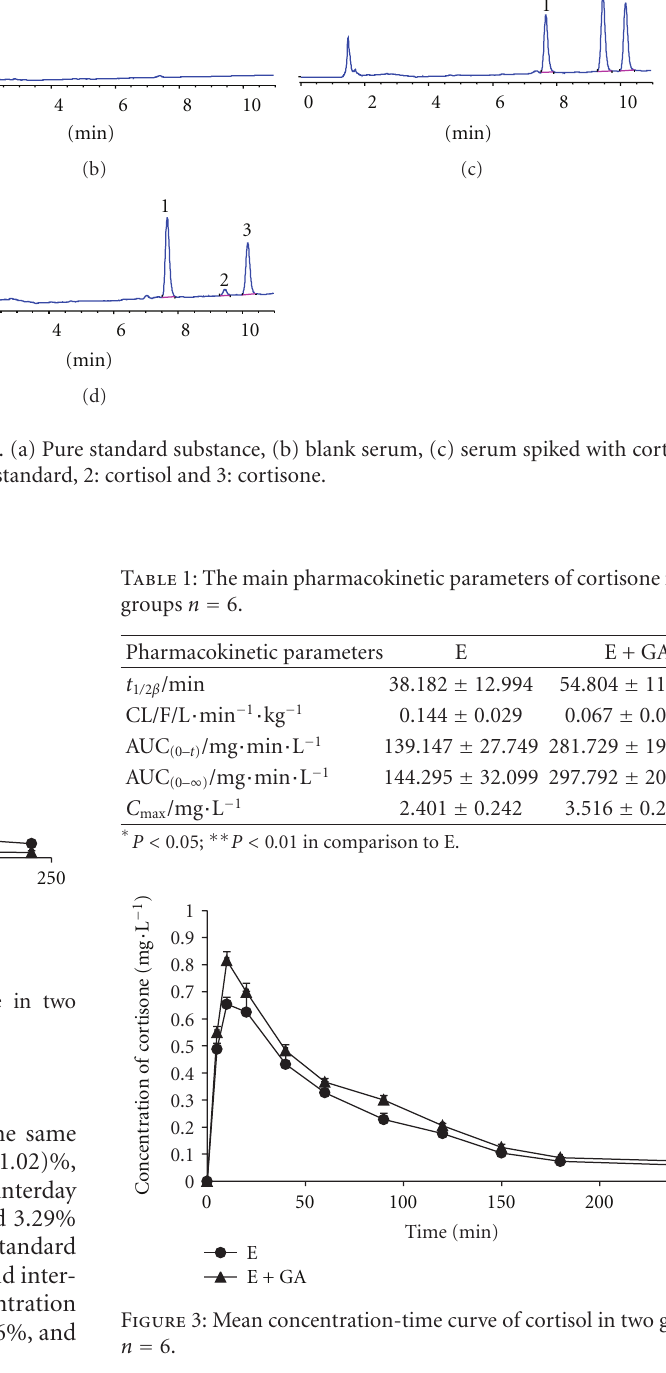
Figure 3: Mean concentration-time curve of cortisol in two groups n =